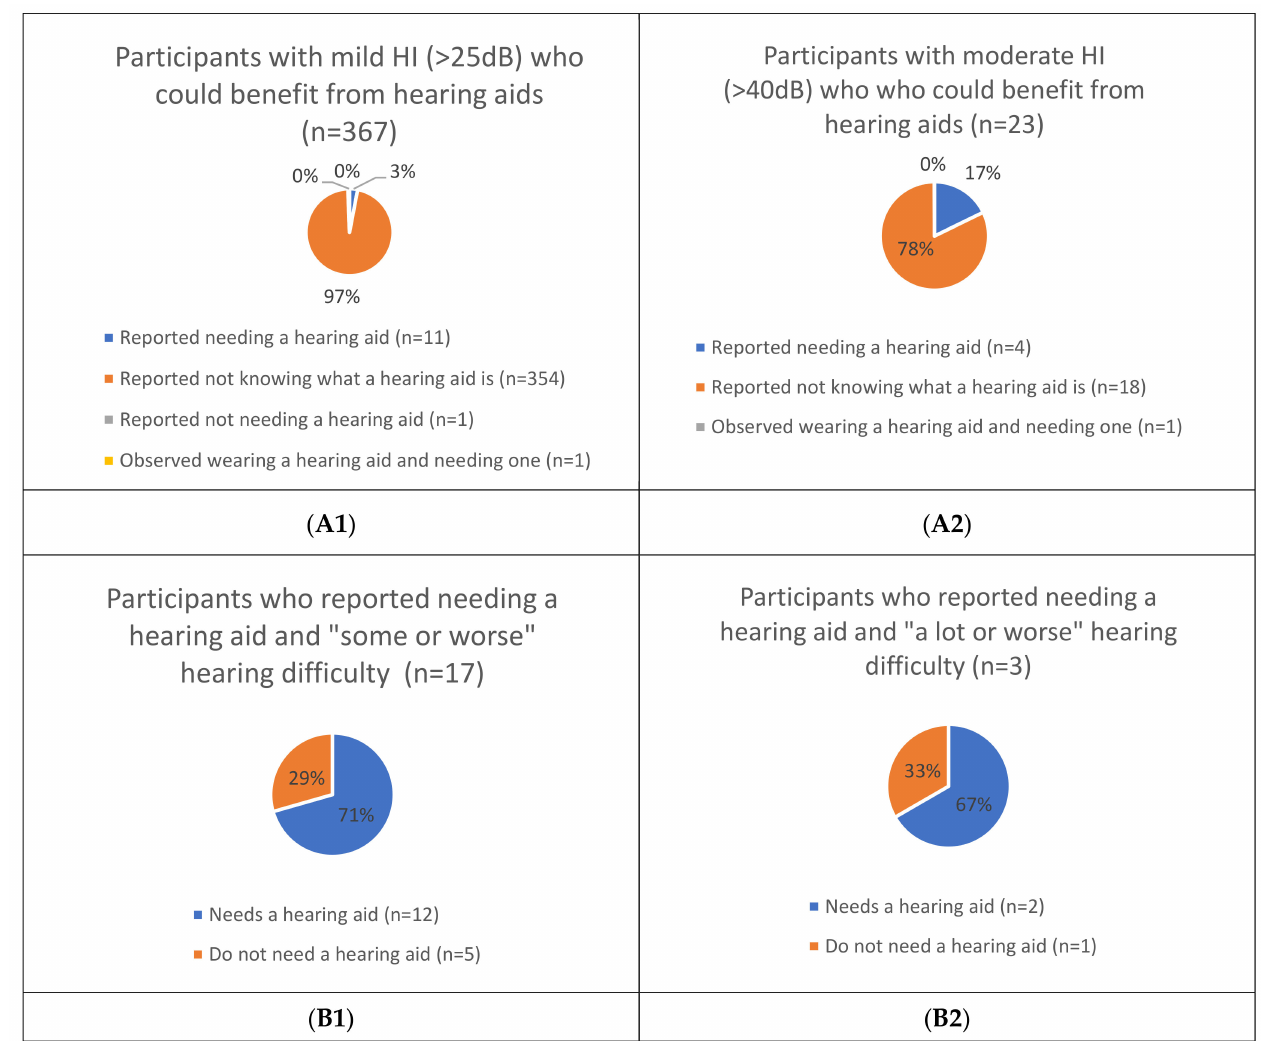
Figure 2. Comparing reported versus clinical impairment assessment unmet/undermet need for hearing aids for both mild and moderate hearing impairment (HI). ( A1 ): Participants with mild HI (>25 dB) who could benefit from hearing aids (n = 367), ( A2 ): Participants with moderate HI (>40 dB) who could benefit from hearing aids (n = 23), ( B1 ): Participants who reported needing a hearing aid with “some or worse” hearing difficulty (n = 17), ( B2 ): Participants who reported needing a hearing aid with “a lot or worse” hearing difficulty (n =